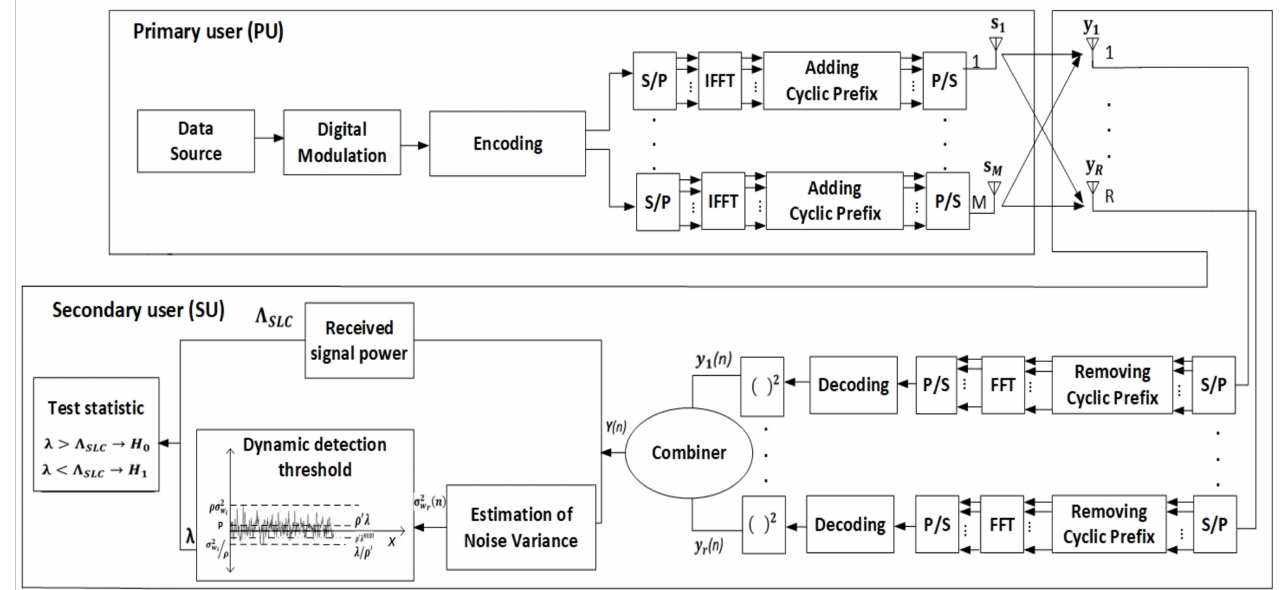
Figure 1. Operational blocks of the MIMO-OFDM communication system employing ED spectrum sensing realized by the SLC